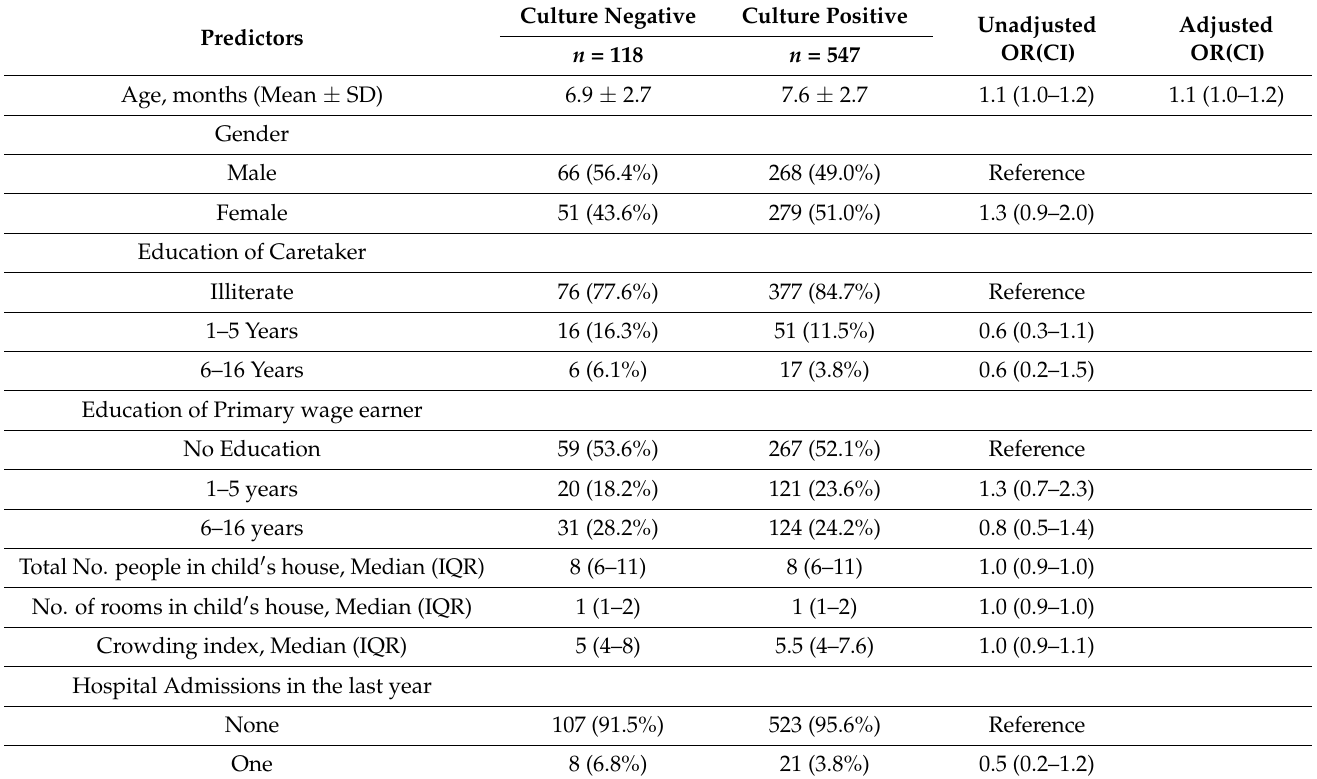
Table 5. Factors associated with a positive nasopharyngeal culture among study